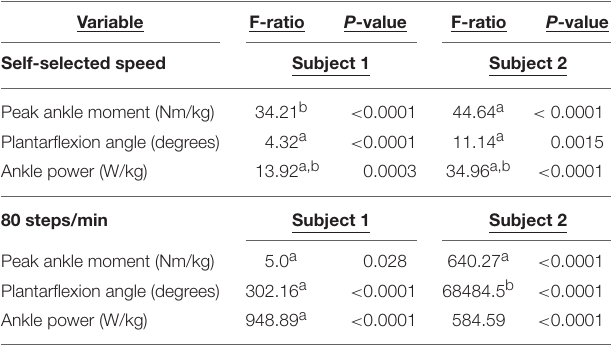
TABLE 4 | Peak sagittal plane ankle moment (Nm/kg), plantarflexion angle (degrees), and ankle power (W/kg) for two subjects while ascending stairs.